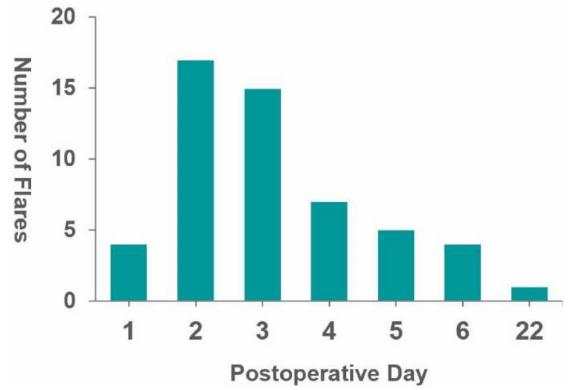
Figure 2. Number of gout flares by postoperative